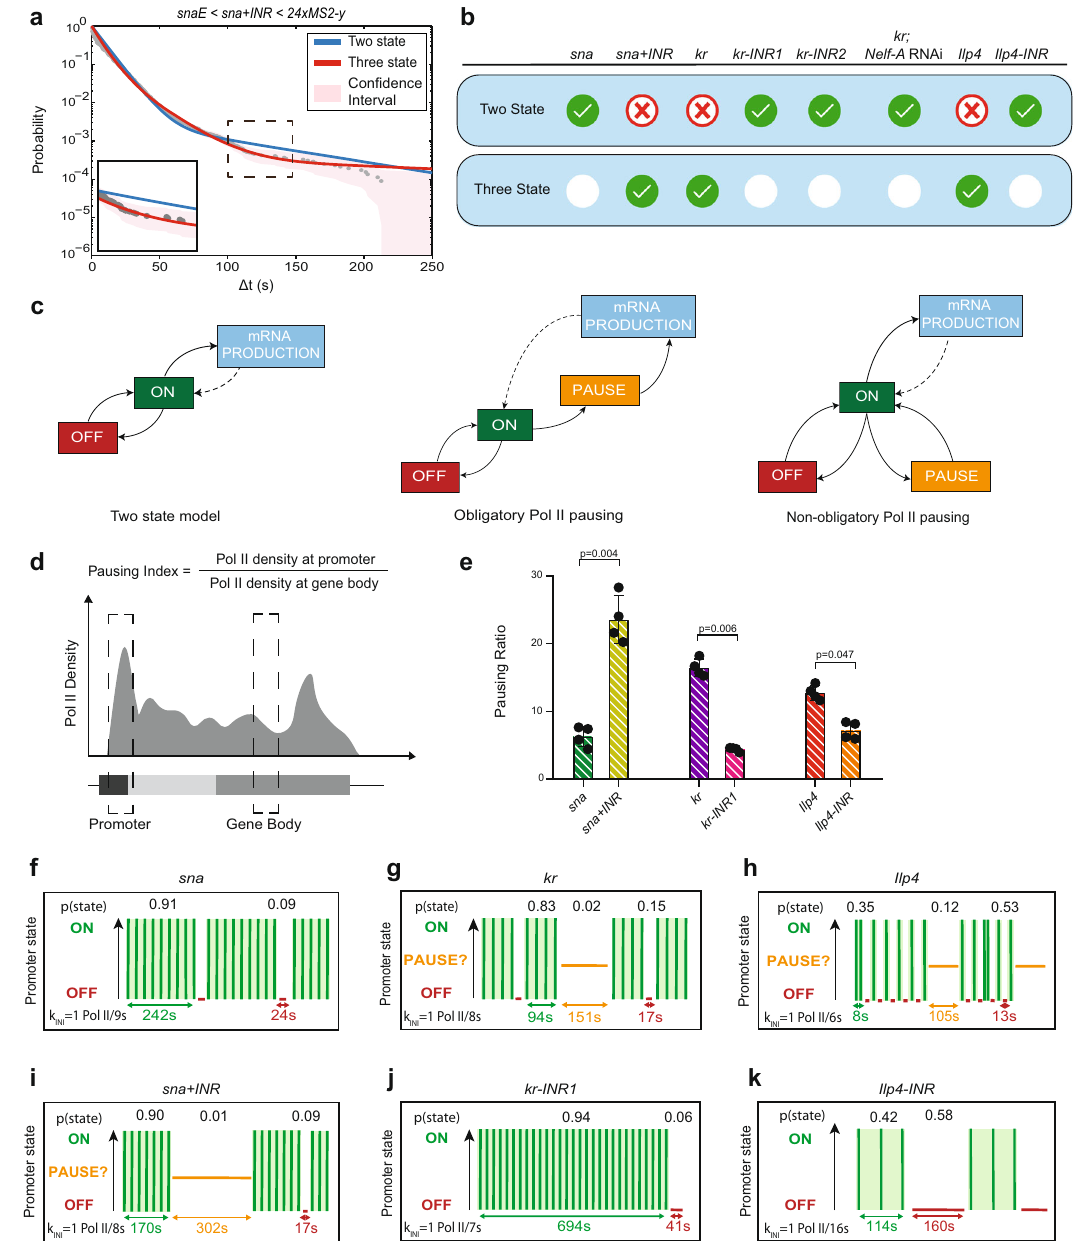
Fig. 6 The INR motif induces an extra promoter state related to pausing. a Survival function of the distribution of waiting times between polymerase initiation events (gray circles). Two-exponential fi tting of the population (blue line), and three-exponential fi tting (red line) estimated using the Kaplan – Meyer method. The shaded region represents 95% con fi dence interval estimated based on Greenwood ’ s formula (see also Supplementary Table 1). b Table indicating the most parsimonious number of states required to fi t each indicated genotype (see also Supplementary Table 1). A green check indicates an accepted fi tting. c Schema of the two-state telegraph model, a three-state model with obligatory pausing, and a three-state model with non-obligatory pausing. d Pausing index calculation. e Pausing index of indicated transgenes measured by ChIP-qPCR (average + SD), n = 4 biological replicates with a Mann – Whitney test. f – k Representation of sna , sna + INR , kr , kr-inr1, Ilp4, and Ilp4-INR estimated bursting dynamics. Permissive ON states are in green, inactive PAUSE states in orange, and inactive OFF states in red. Statistics: snaE < sna , 216 nuclei, 3 movies; snaE < sna + INR , 236 nuclei, 4 movies; snaE < kr , 243 nuclei, 4 movies; snaE < kr-INR1 , 342 nuclei, 5 movies, snaE < snaTATAlight , 353 nuclei, 6 movies; snaE < snaTATAlight + INR , 193 nuclei, 3 movies; snaE < Ilp4 , 114 nuclei, 2 movies ; snaE < Ilp4-INR , 48 nuclei, 2 movies. See Supplementary Movies 1, 4 – 6, Supplementary Table the inducible RNAi/GAL4 system with our MS2/MCP-GFP reporter promoter dynamics, with a reversion to a two-promoter-state to examine the transcriptional dynamics of the three-state kr pro- dynamic and much less frequent long waiting times (Fig. 6b and moter. We performed live imaging of the kr -MS2 transgene and Supplementary Fig. 9e-f ʼ , arrowheads, Supplementary Table 1). These compared a control white RNAi knockdown with embryos harboring data, combined with the effect of INR mutations in cis , led us to a maternal depletion of Nelf-A (evaluated to >85% knockdown by propose that one of the two inactive promoter states observed with RT-qPCR, Supplementary Fig. 9a, Supplementary Movies 7 and 8). the three-state promoters could be associated with promoter- Remarkably, reducing Nelf- A transcript levels led to a change in kr proximal polymerase pausing.